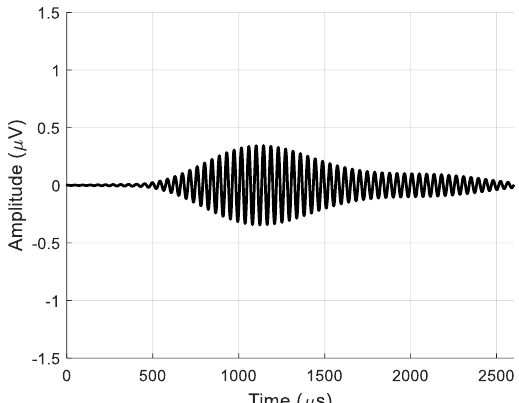
Figure 24. Signal from single air-coupled receiver obtained after 2D spatial – temporal filtering at x = 55.1 mm.